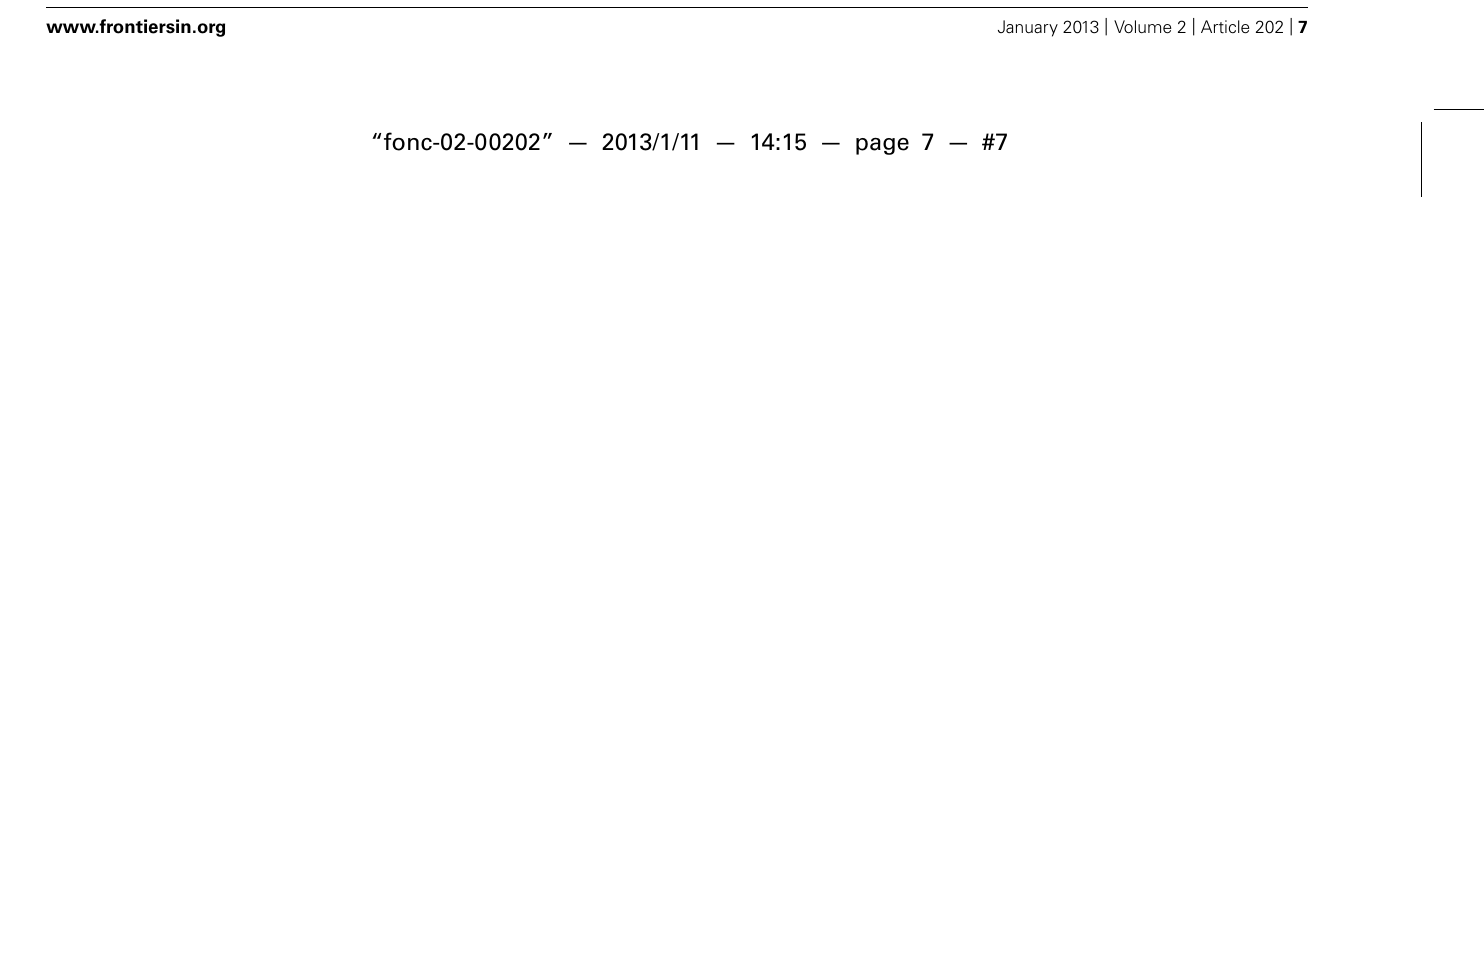
immunosuppression.The tissue of origin is highlighted by the blue bars on top and gene expression is shown as a row-normalized heatmap. Red denotes under-expressed and violet denotes overexpressed relative to the population mean. Dendrogram indicates the degree of similarity among genes (rows) or samples (columns) using theWard’s minimum distance method in